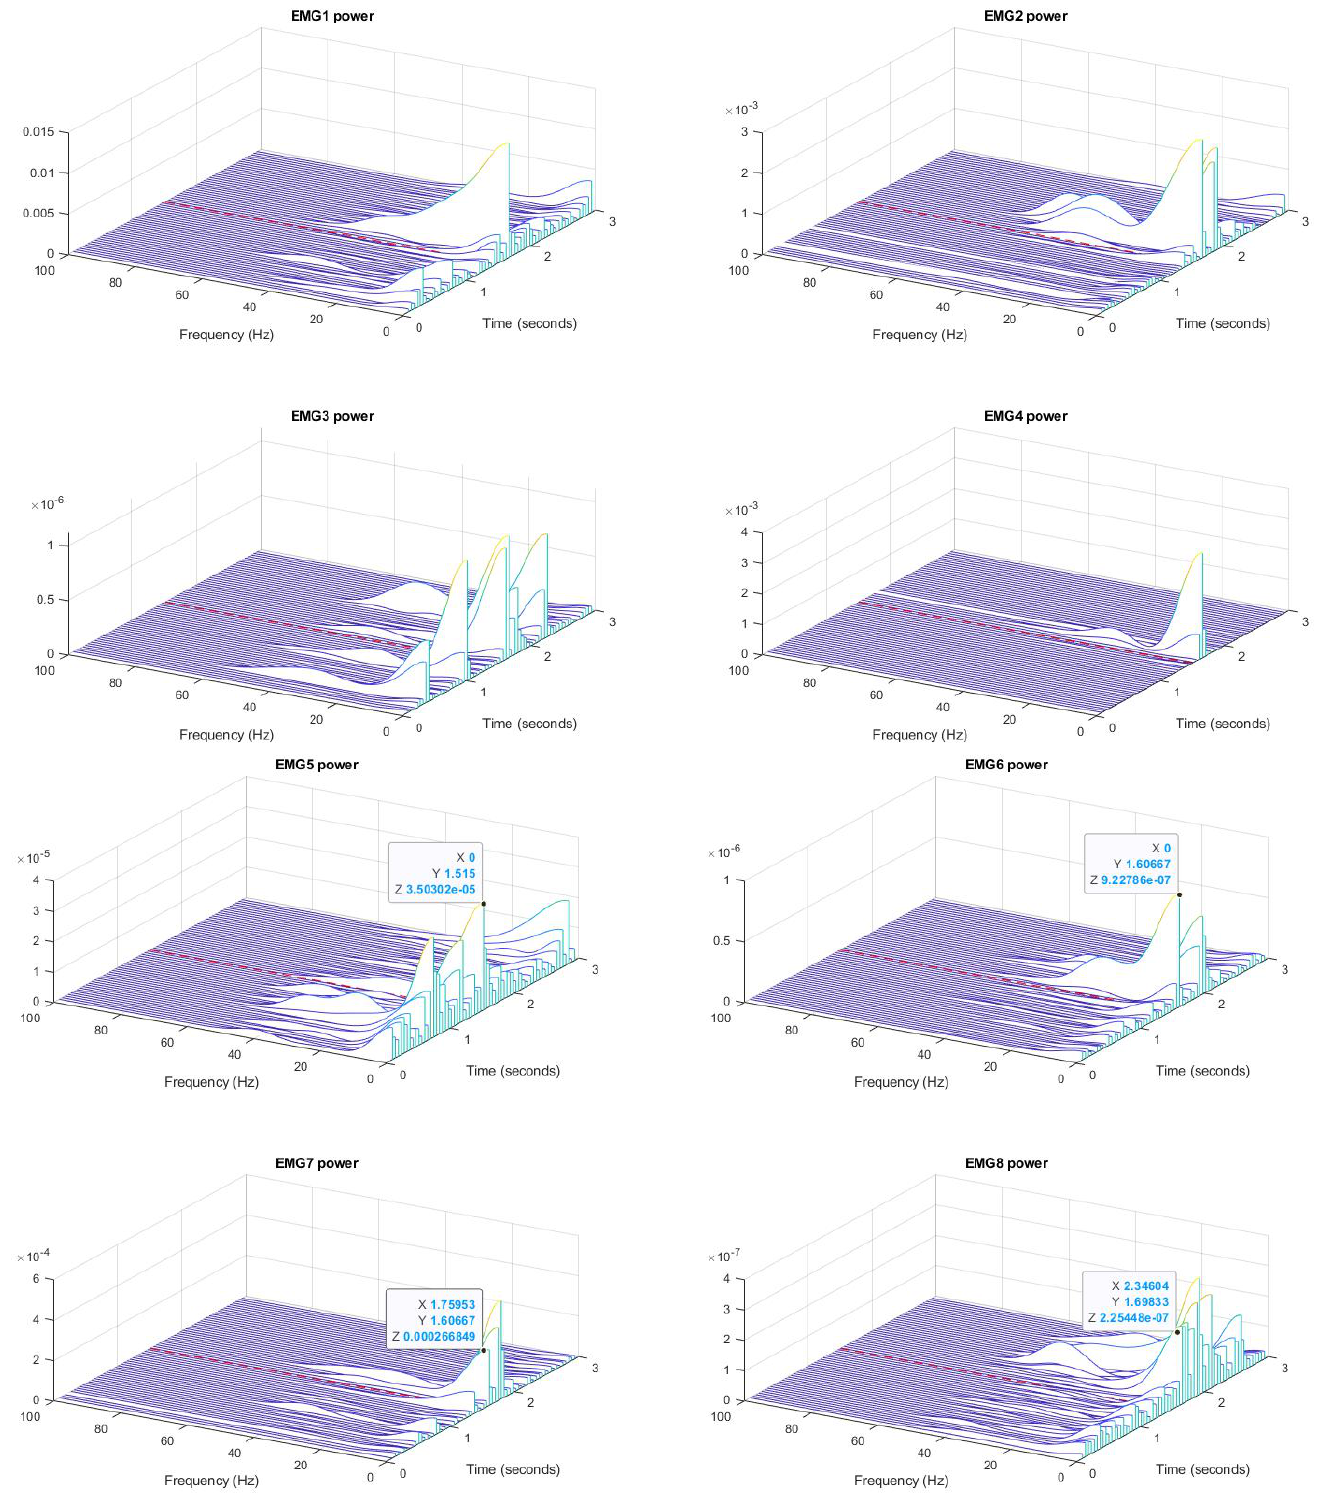
Figure 4. Power spectrum for one trial of subject number 7. EMG1 to EMG8 represent Deltoid Anterior, Pectoralis Major Clavicular, Pectoralis Major Sternal, Biceps Brachii, Trapezius Descending, Deltoid Posterior, Latissimus Dorsi and Triceps Brachii, respectively. The red dashed line represents the perturbation instant.